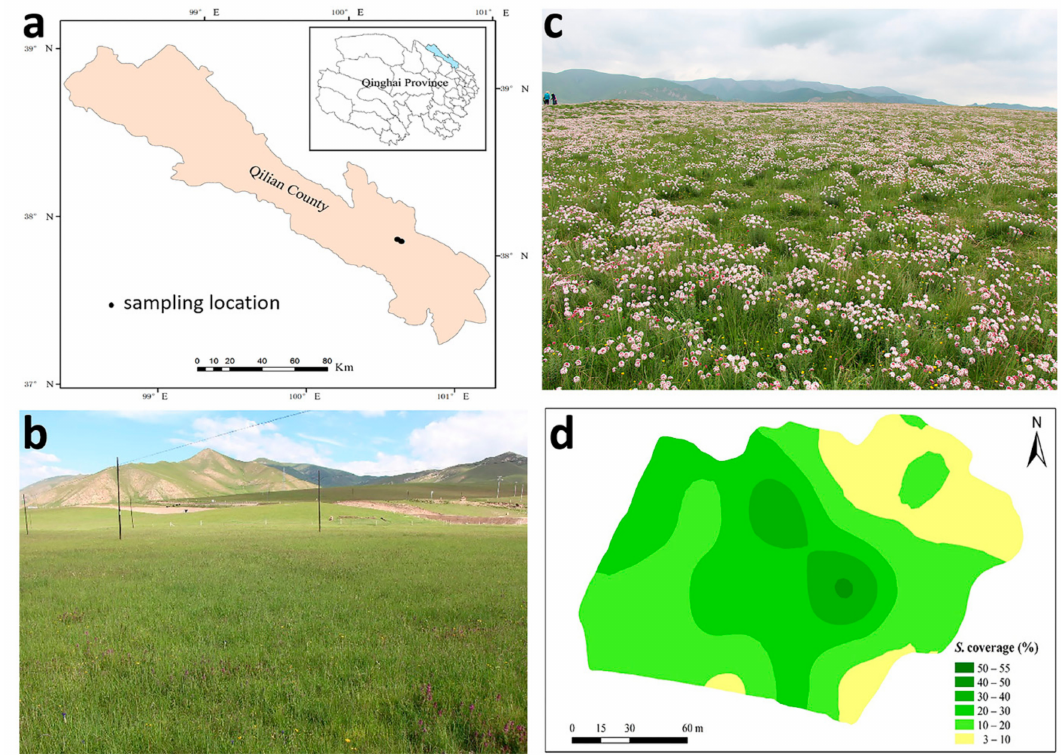
Figure 1. ( a ) Sampling location in Qilian County on the Qinghai–Tibetan Plateau; ( b , c ) uninvaded and invaded sites; and ( d ) S. chamaejasme coverage on the invaded